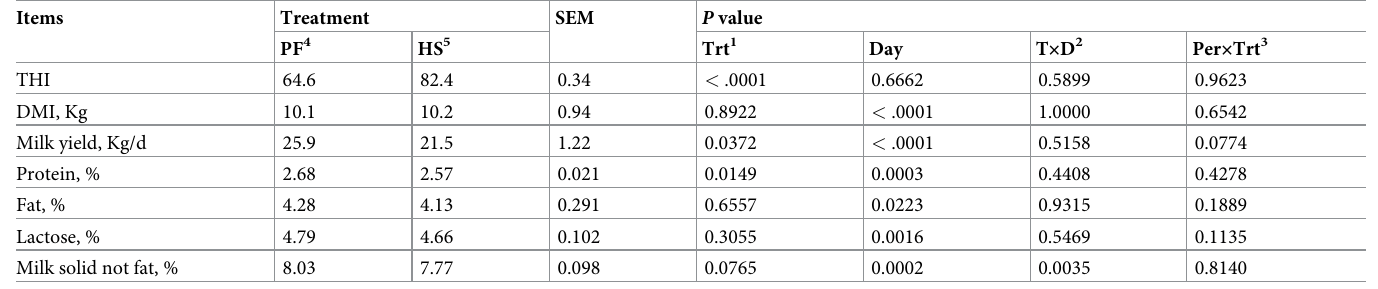
Table 1. THI and effects of pair-fed or heat stress on feed intake, milk yield and milk compositions.